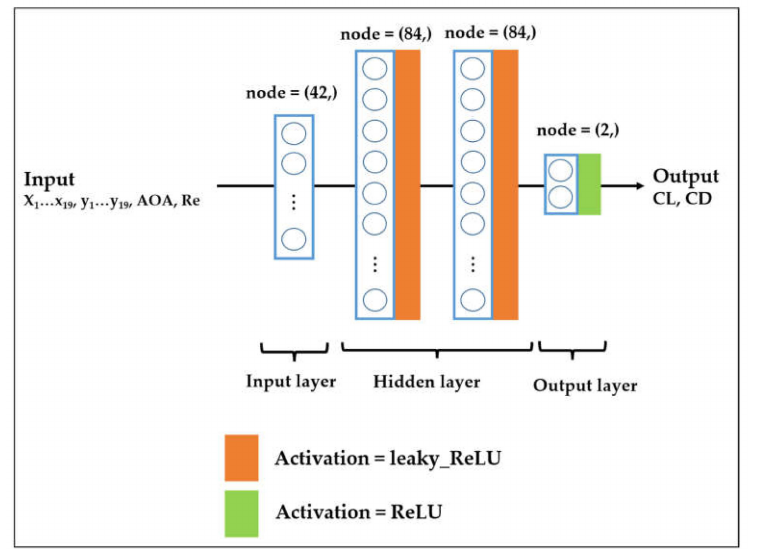
Figure 4. The schematic diagram of the implemented